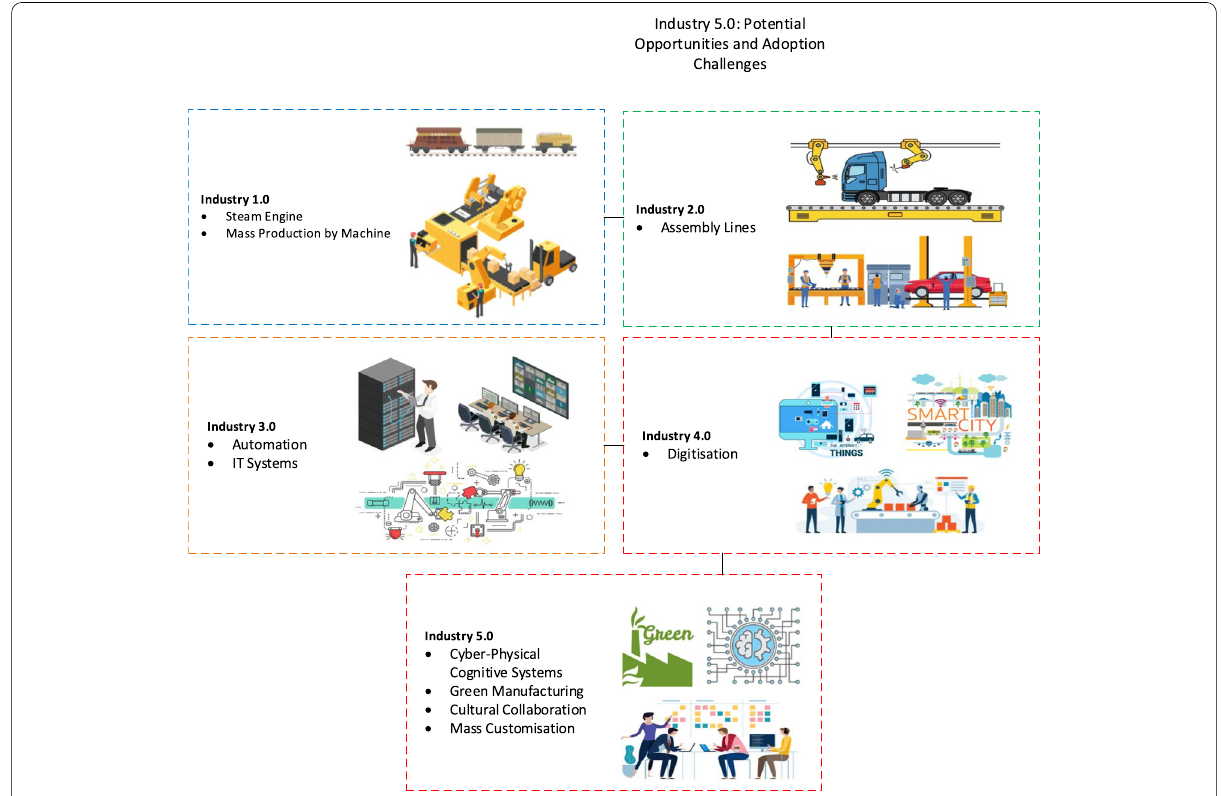
Fig. 1 Industrial Evolution from Industry